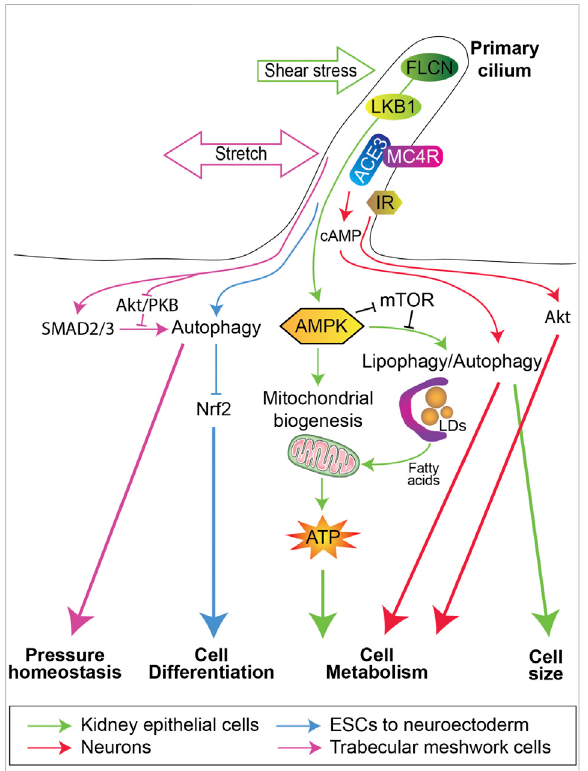
FIGURE 1 Primary cilium and autophagy in the regulation of cell fate. Shear stress in kidney epithelial cells (Green arrows) activates the folliculin (FLCN)/LKB1/AMPK/mTORC1 cascade to induce on